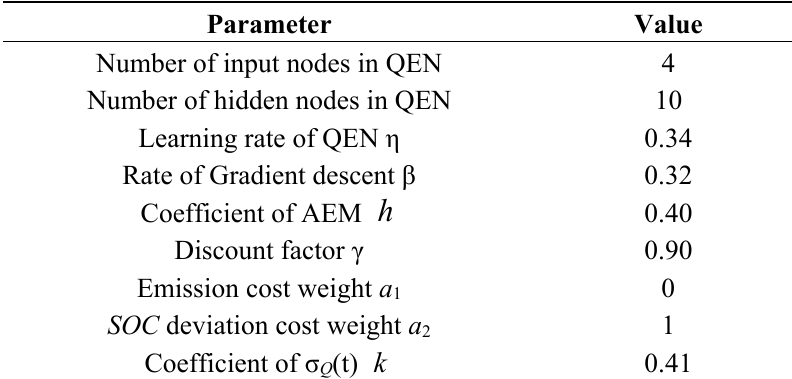
Table 2. Summary of FQL algorithm